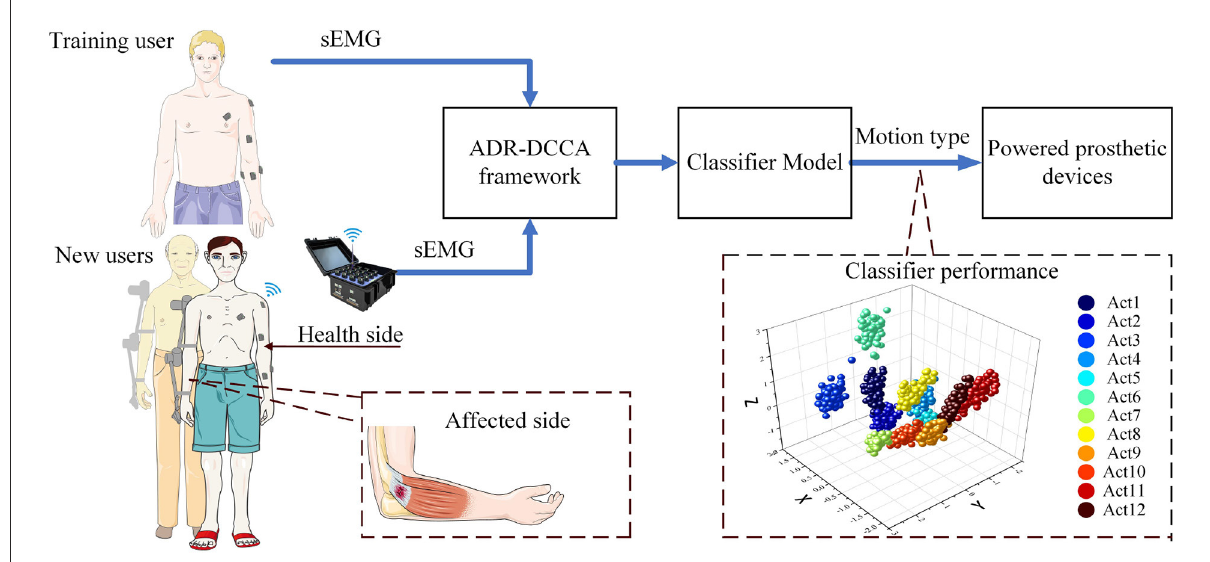
FIGURE1 A multi-user health-side-driven rehabilitation system with an ADR-DCCA framework. The sEMG signals are collected from the healthy side arm of a new user and processed accordingly in the ADR-DCCA framework. The recognition is done by an upper limb exoskeleton